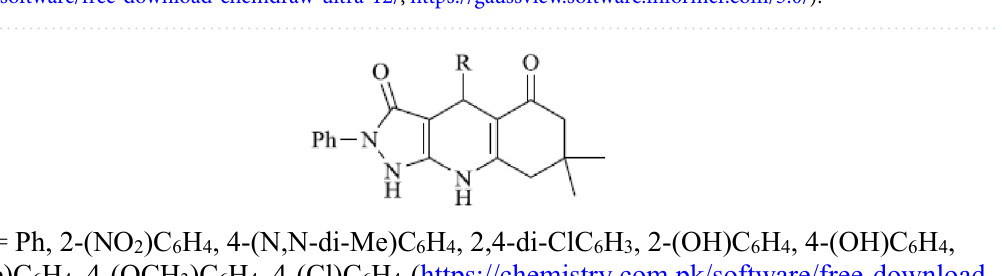
Figure 2. Optimized pyrazoloquinolines derivatives’ structure (R = Ph, 2-(NO 2 )C 6 H 4 , 4-(N,N-di-Me)C 6 H 4 , 2,4-di-ClC